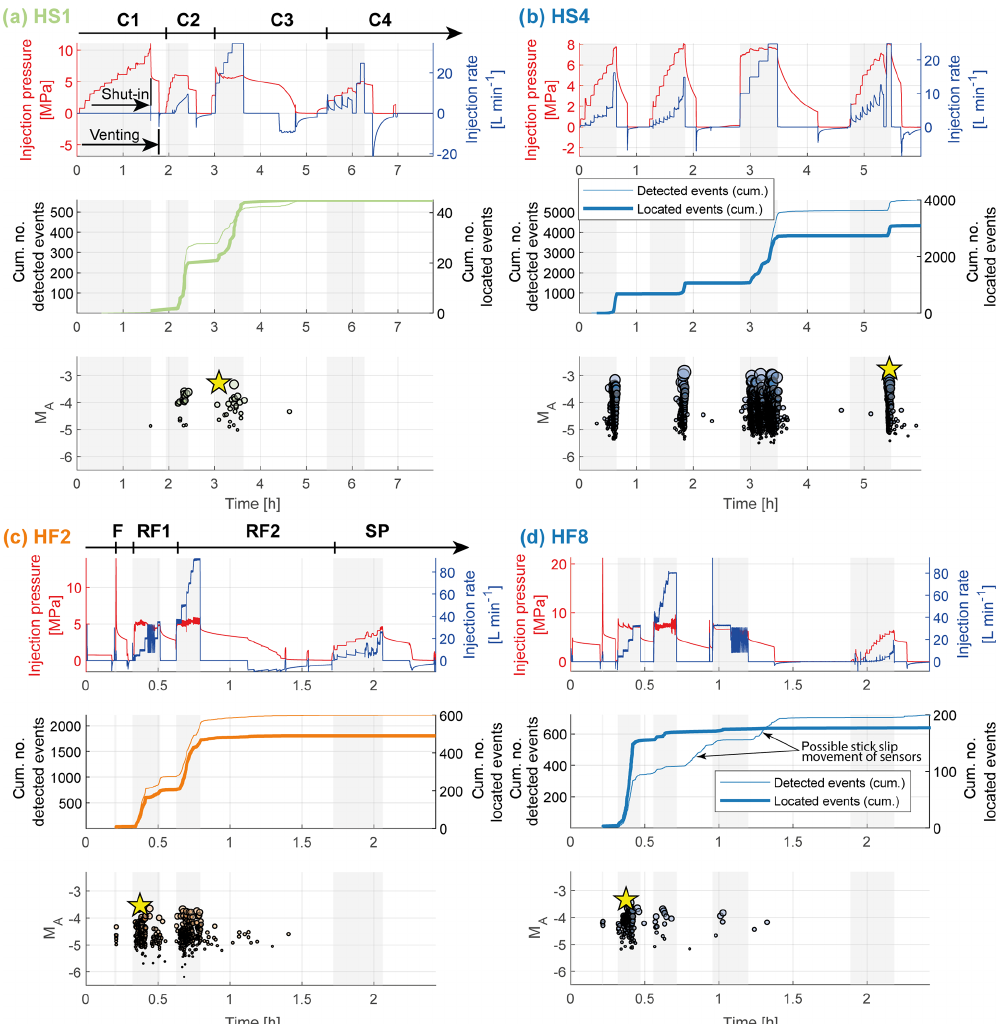
Figure 4. (a) Temporal seismicity evolution of experiment HS1 performed in shear zone S1.3 and (b) of experiment HS4 in shear zone S3.1, along with (c) the temporal seismicity evolution of experiment HF2, which was performed north of the S3 shear zones, and (d) the temporal seismicity evolution of experiment HF8, performed south of the S3 shear zones. In addition to the injection rate and pressure, the cumulative number of events and magnitudes M A are shown. The largest-magnitude event is indicated with a yellow star. The shaded area on the plots indicate the pumping periods during an experiment (the temporal seismicity evolution of the remaining experiments is shown in Sect. S3, of this paper). Panel (a) also shows an example for a HS injection protocol with injection pressure and injection flow rate, divided into the four cycles, including shut-in and venting phases in each cycle. Panel (c) shows an example of a HF injection protocol with injection pressure and injection flow rate, including formation break down cycle (F), refrac cycles (RFs), and the final step pressure (SP) injection experiment. All of the cycles include a shut-in phase, but only after some cycles a venting phase is included. The yellow stars indicate the largest events induced in a respective